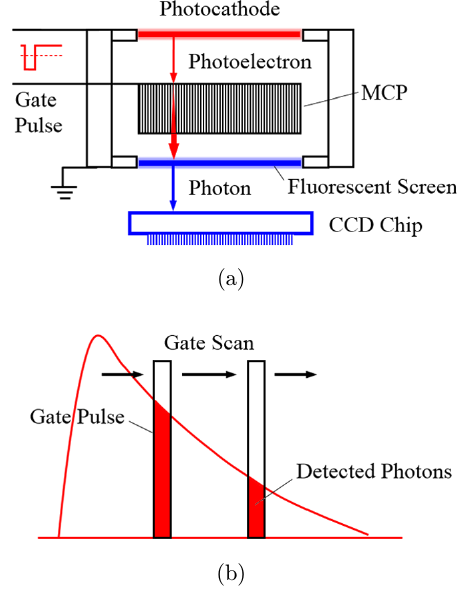
Fig. 5. (a) Gated image intensi¯er. MCP: microchannel plate. (b) The °uorescence decay is sampled by taking consecutive images for di®erent delays of the gate